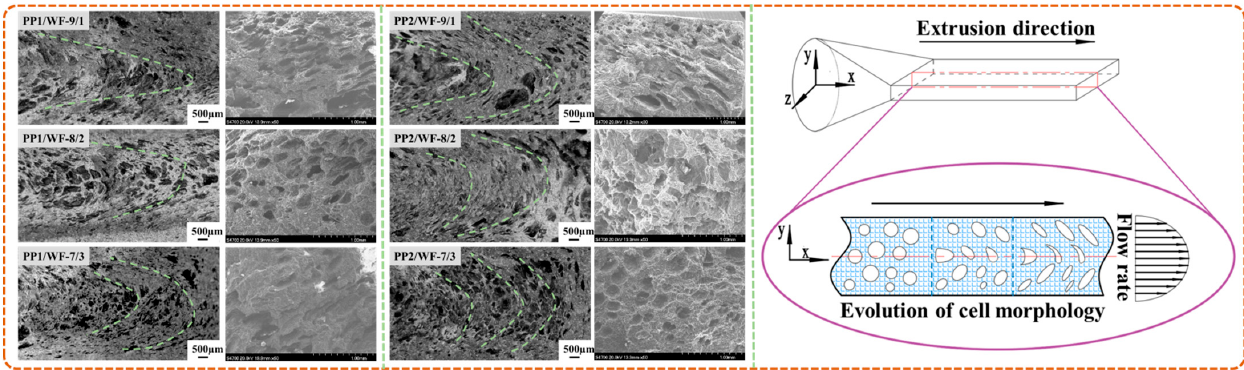
Figure 12. Cell morphology on radial section of samples with different WF content and the evolution process of bubble structure.